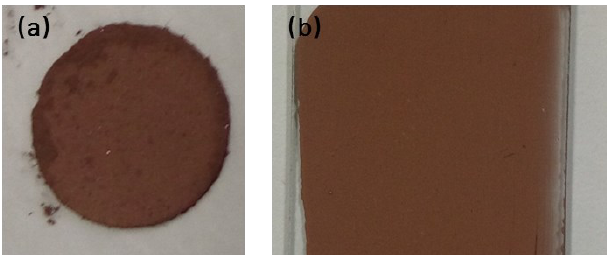
Figure 11. ( a ) The circle flake pressed under 20 MPa; ( b ) the film prepared by copper conductive paste on the glass substrate.